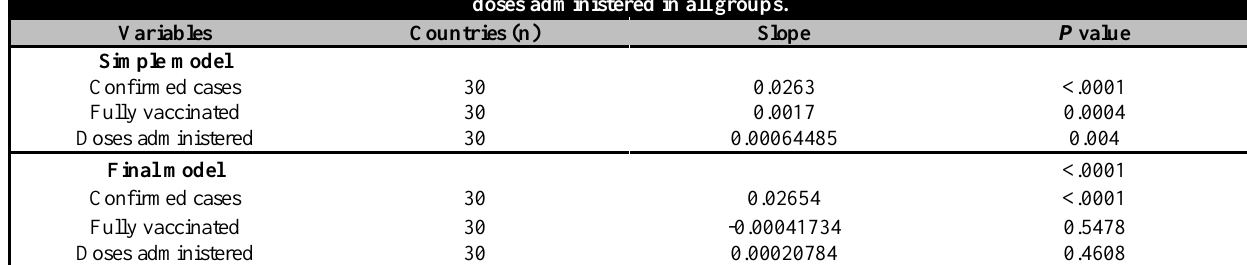
Table 4: Simple and multiple linear regression to estimate the relation of deaths to confirmed cases, fully vaccinated, and doses administered in all